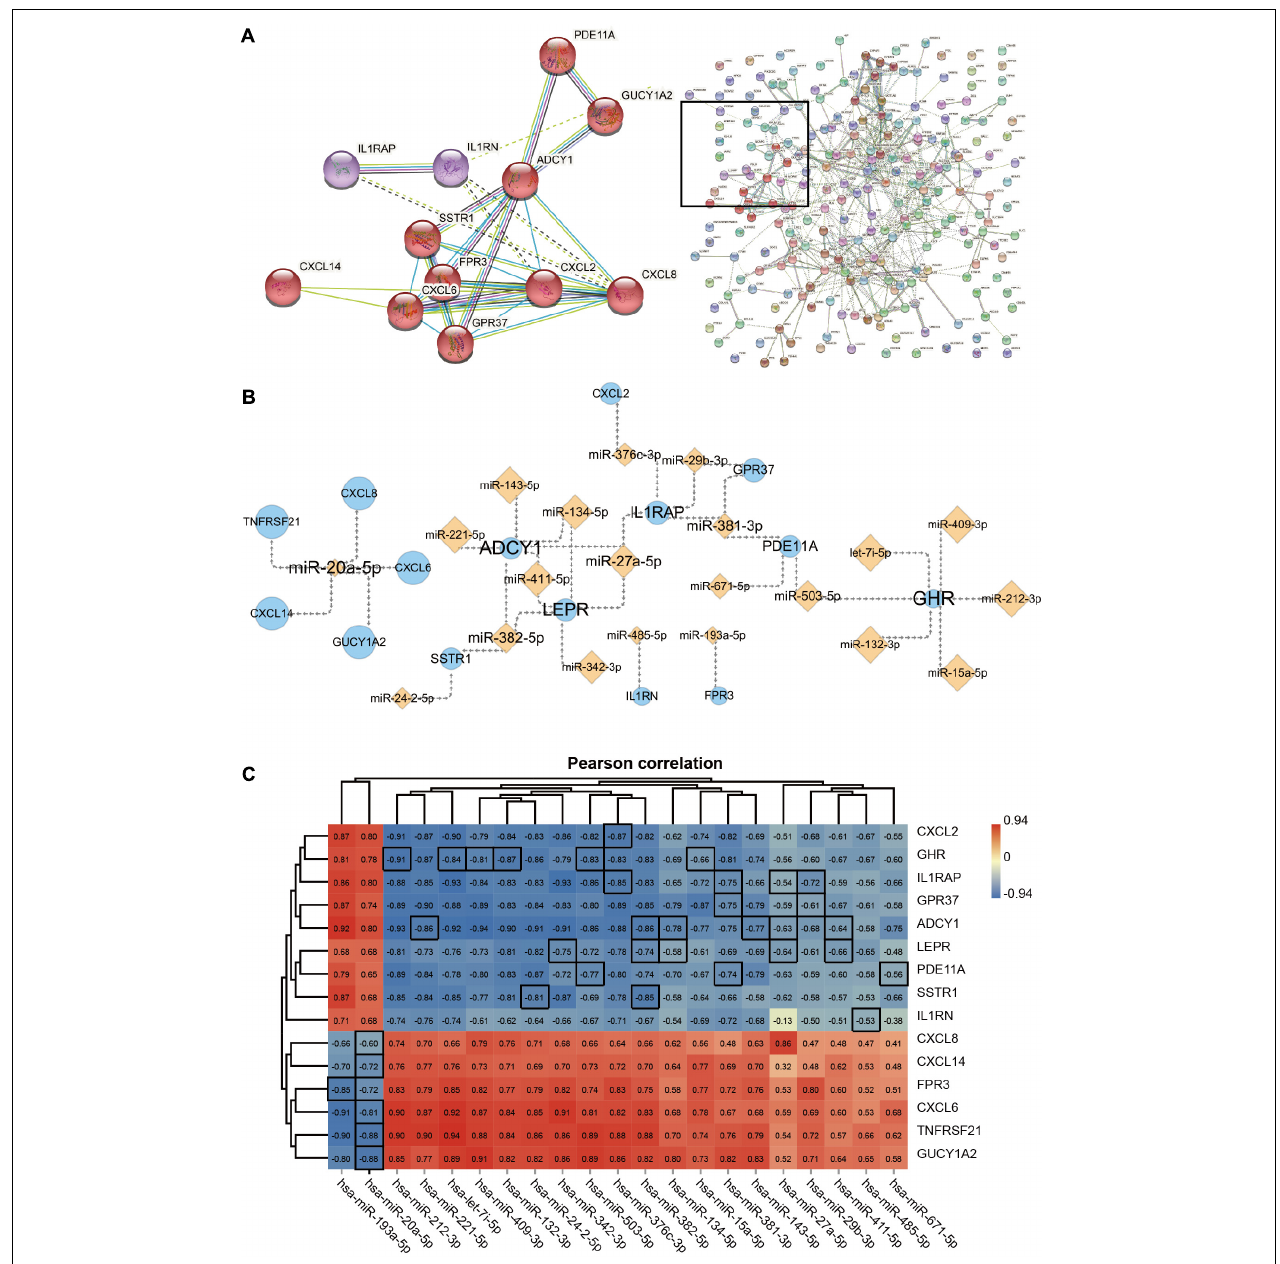
FIGURE 5 | The network of Hub genes and miRNAs. (A) Protein-protein interaction (PPI) network and 12 DEGs in the core modules. MCL parameter set to 3. (B) Regulatory network of 15 Hub genes with miRNAs. Orange diamond points represent miRNAs, and blue circle points represent Hub genes. Point and label size represent the node importance index: points, from large to small, represent high to low Neighborhood Connectivity; labels, from large to small, represent high to low Degree. (C) Heat map showing Pearson’s correlation analysis of hub genes with miRNAs. The screened miRNAs show moderate to very strong negative correlations with their target genes. The correlation coefficients of pairs of molecules with target-regulated relationships are highlighted using black borders. Pearson correlation coefficient cut-off of ≥ 0.6. All correlation analyses in the graph are adj. p ≤